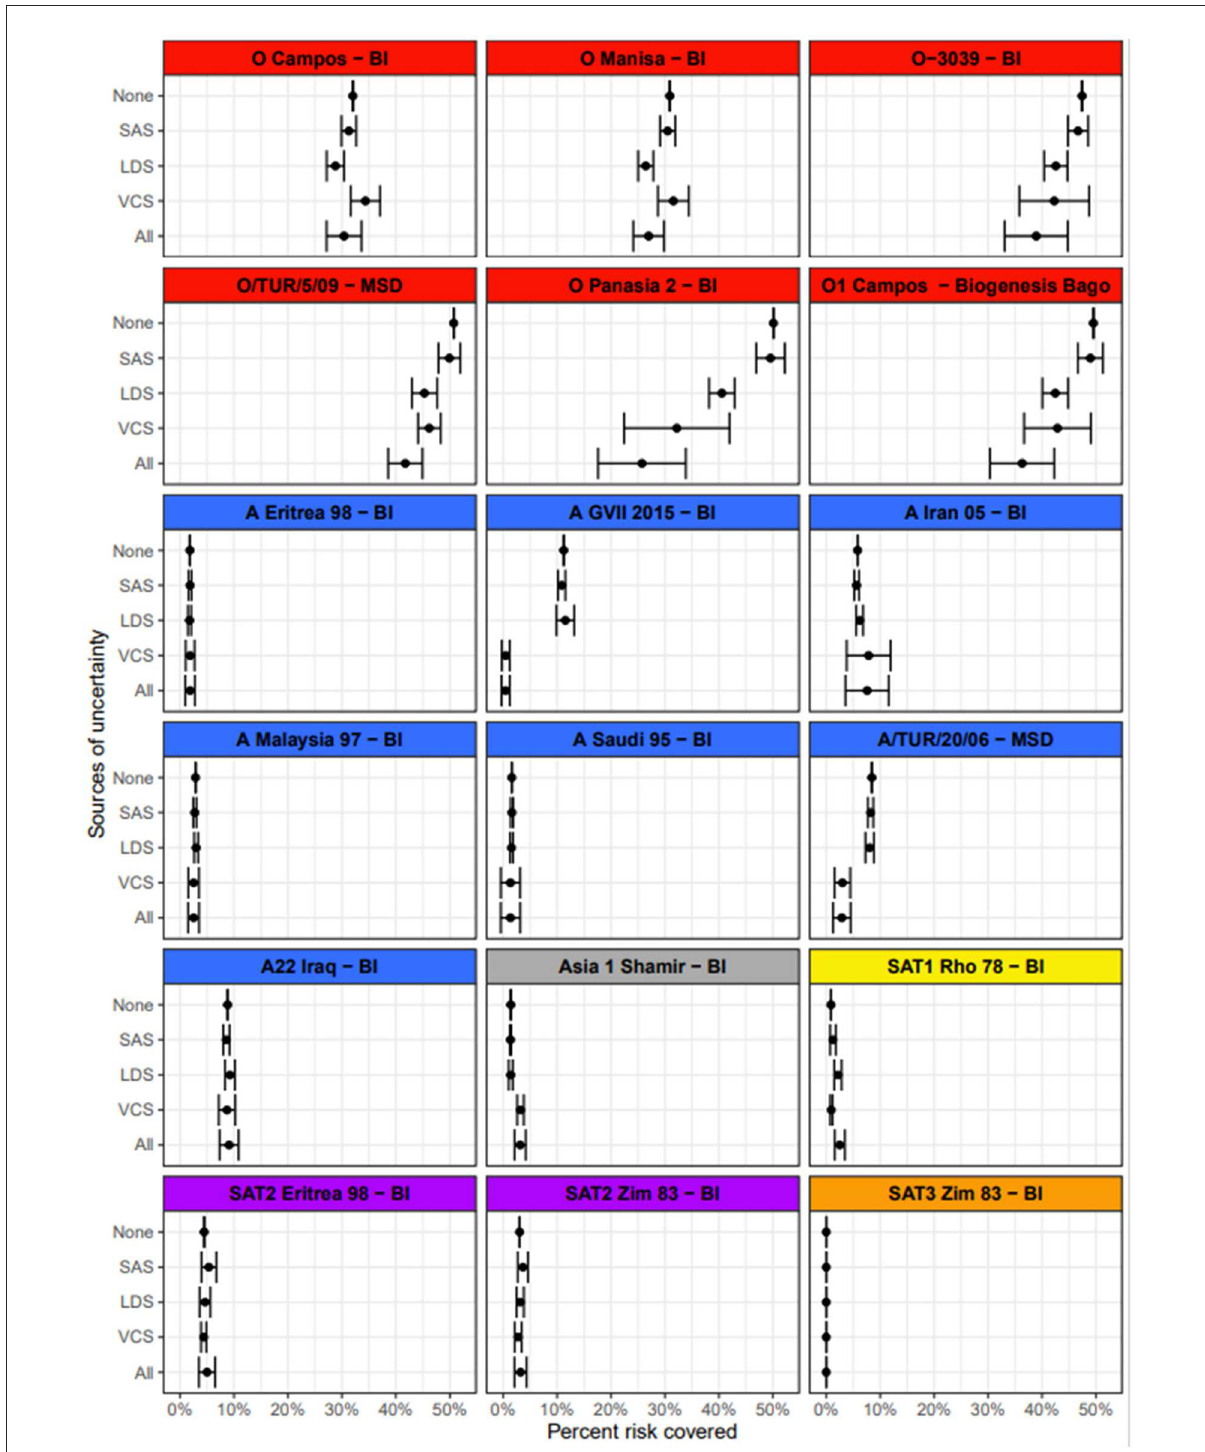
FIGURE6 The mean and standard deviation for the percentage risk coverage out of the total risk needing to be covered, for each vaccine. The sources of variance are broken down; none indicates how the tool would work as it is, in the absence of any stochasticity. SAS is uncertainty in the source area scores (set to “mid” here), with no variation introduced from other inputs. LDS is uncertainty in the lineage distribution scores (set to “mid” here), with no variation introduced from other inputs. VCS is variation in the vaccine coverage scores based on the breadth of r 1 values from vaccine matching tests and the number of tests performed, with no variation introduced from other inputs. All indicates uncertainty in all parameters, using a “mid” level of uncertainty in the LDS and